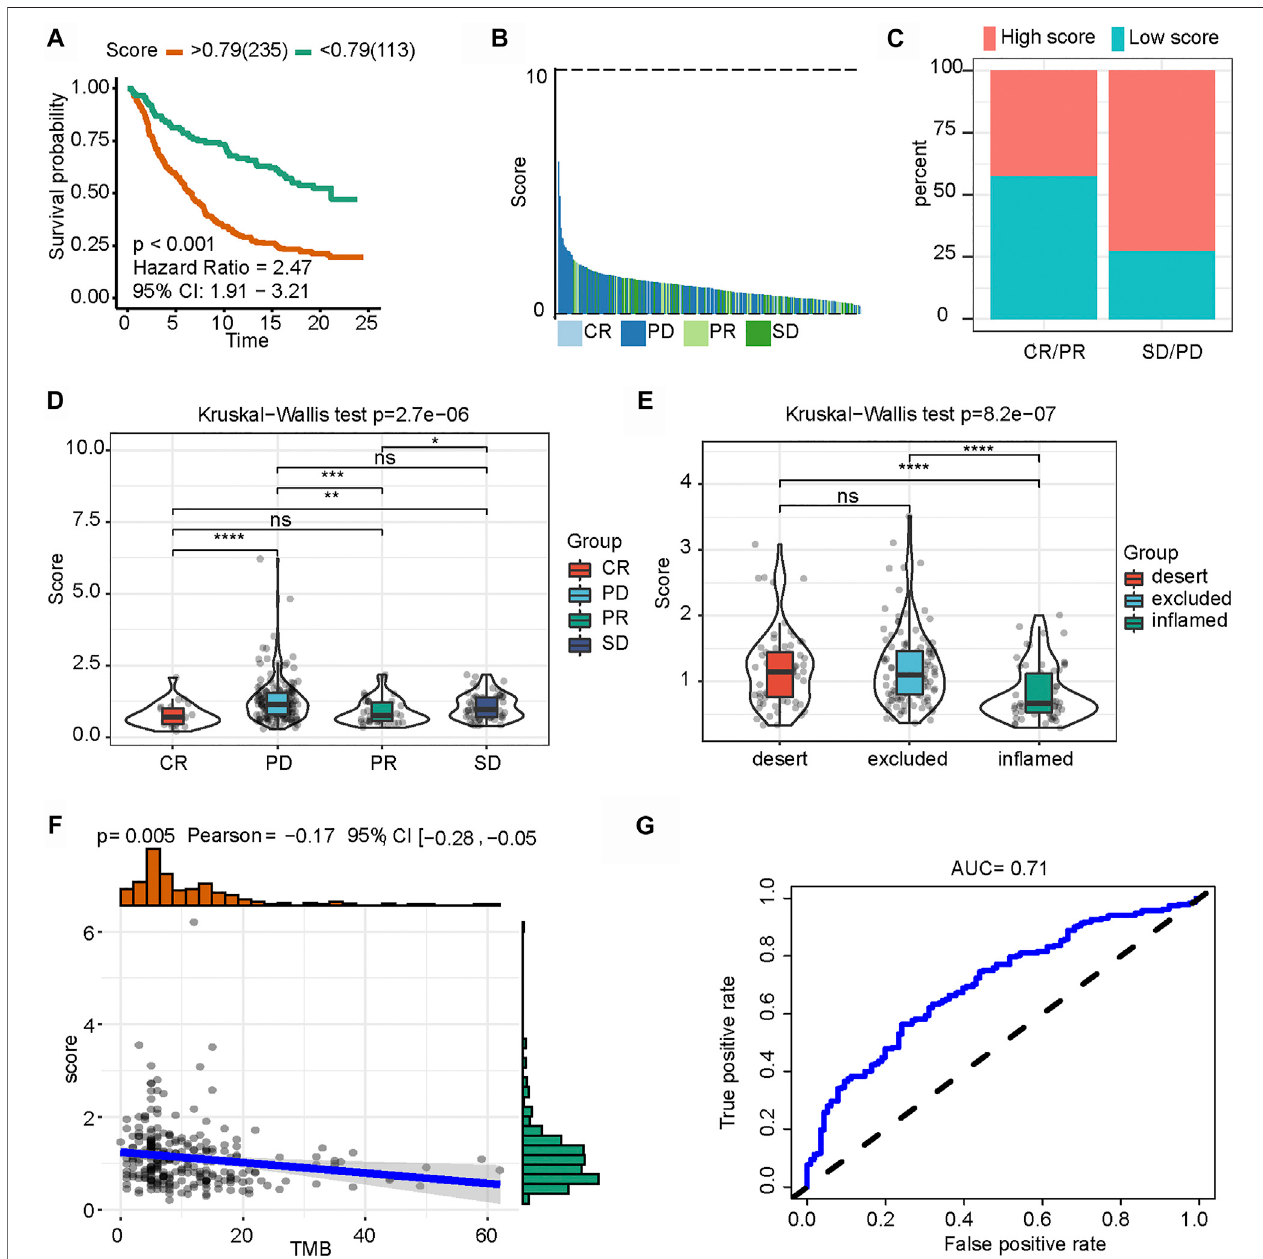
FIGURE 7 | Role of N 6 -methyladenosine-related immune score (m6A-IS) in immunotherapy. (A) Patient survival analysis de fi ned by the high- ( n (cid:1) 235) and low- m6A-IS ( n (cid:1) 113) groups based on the IMvigor210 cohort (log-rank test: p < 0.001). (B) Waterfall plot of m6A-IS for distinct clinical response groups based on the IMvigor210 cohort. (C) Stacked bar chart representing the percentage of clinical response patients assigned to two m6A-IS subgroups in the IMvigor210 cohort. High- score, red ; low score, blue . (D) Boxplot of m6A-IS for distinct clinical response groups via the Kruskal – Wallis test ( p < 0.001). (E) Differences in m6A-IS among threedistincttumorimmunephenotypesintheIMvigor210cohortbytheKruskal – Wallistest( p < 0.001). (F) Spearman ’ scorrelationanalysisbetweenm6A-ISandtumor mutation burden ( p (cid:1) 0.005). (G) Predictive value of the quanti fi cation of m6A-IS in patients treated with anti-PD-L1 immunotherapy (AUC (cid:1) 0.71).